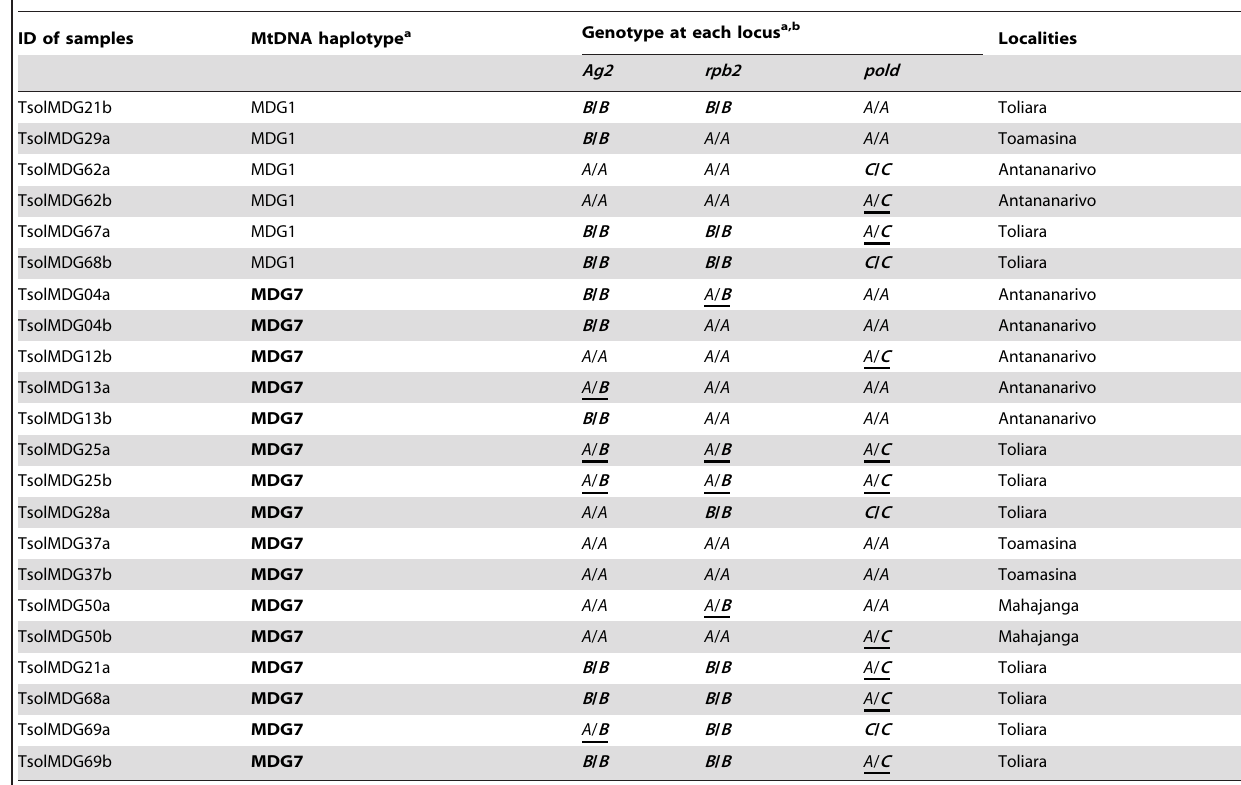
Table 4. Genotypes of T. solium showing nuclear-mitochondrial discordance.